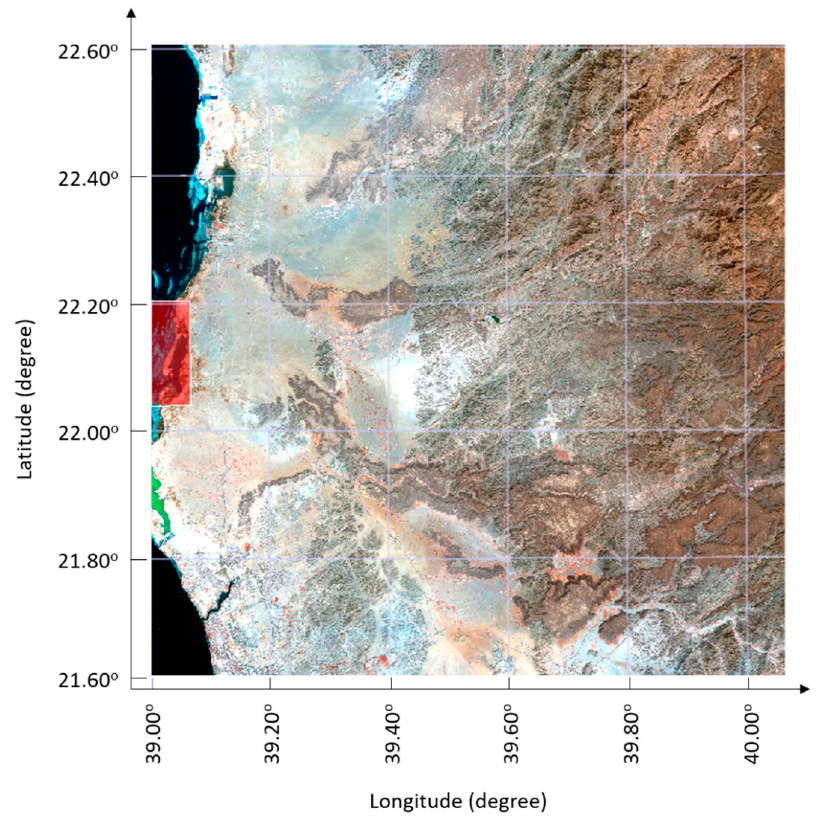
Figure 3. Near-infrared (NIR)-green-blue color-infrared-like image of Level-1C product from Sentinel-2A satellite (size = 100 km × 100 km) and study area (red box).